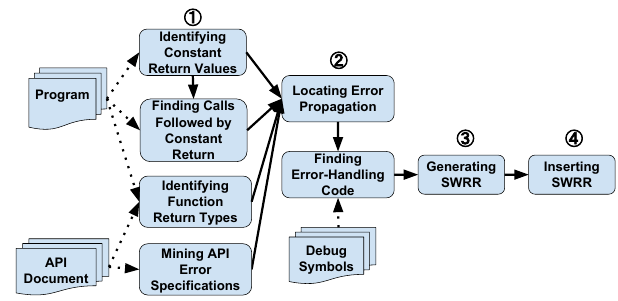
Figure 4. Workflow of RVM: each rounded rectangle represents a step in RVM; each circled number denotes a phase that consists of one or more steps underneath the circled number; dotted arrows denote input data, while solid arrows denote the order of